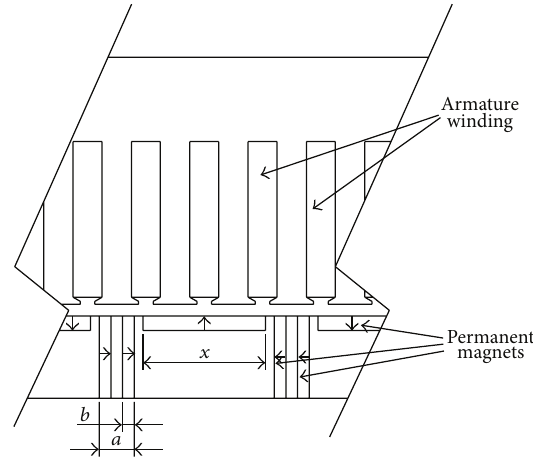
Figure 4: The local section of the new secondary structure. Table 2: The structure parameters of permanent magnet. The structure parameter